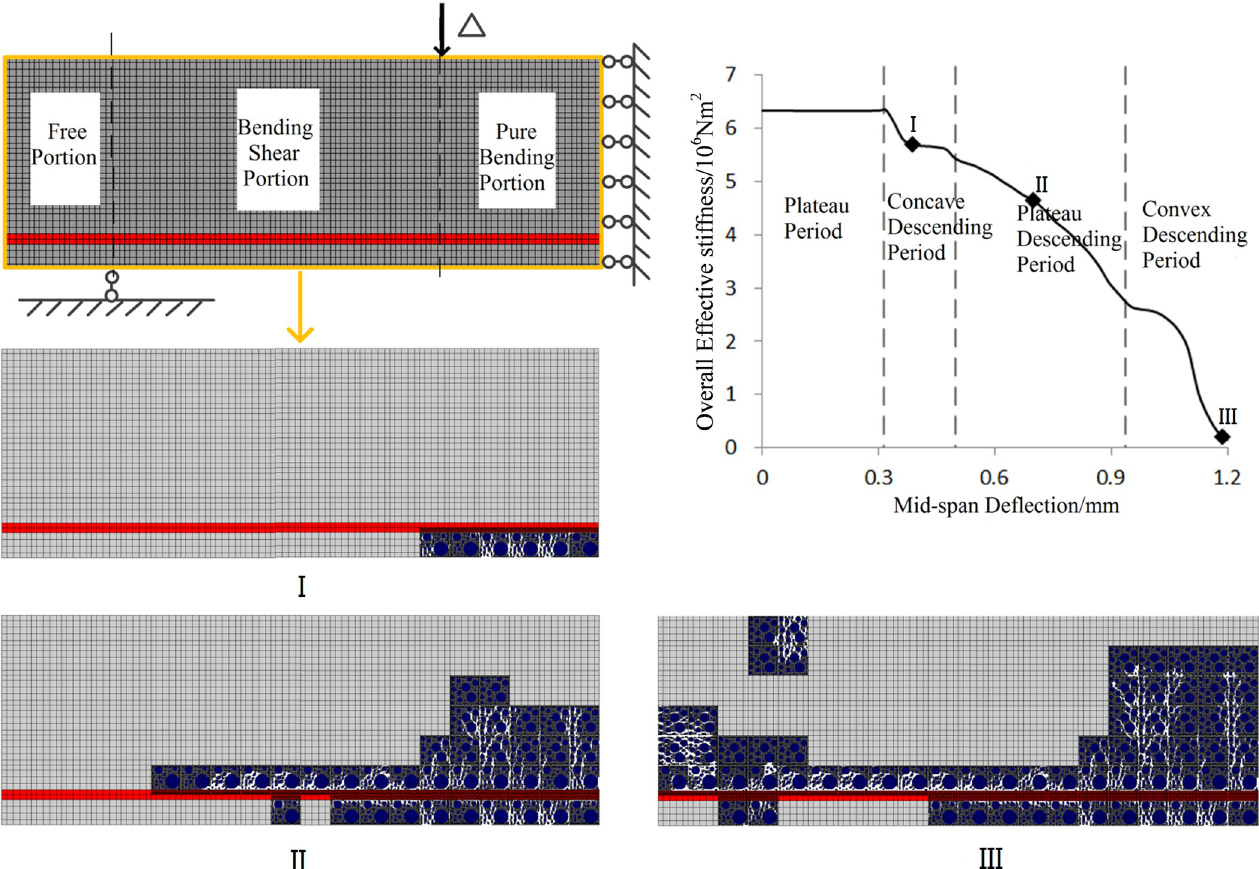
Fig 19. Mesoscopic-damage evolution process of the four-point bending beam. There are three damage states of I, II and III, which correspond to the points I, II and III that are located on concave descending period, steady descending period and convex descending period of the curve of overall effective stiffness respectively.